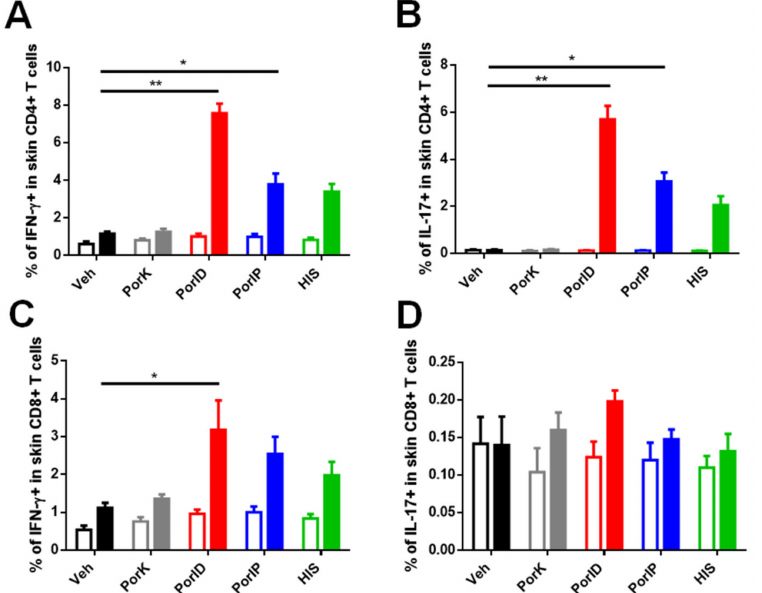
Figure A2. Percentage of functional CD4+ and CD8+ T cells in skin. C57BL/6J mice were injected intradermally in the ear with vehicle (Veh), proteinase K-digested porins (PorK), porins (PorID), or intraperitoneally with porins (PorIP) or heat-inactivated S . Typhi (HIS) at day 0. All groups were boosted at day 14 with porins injected intradermally in the ear. Count of the percentage of IFN- γ - ( A ) and IL-17- ( B ) producing CD4+ T cells found in skin at day 28. Same population percentages were analyzed for skin CD8+ T cells ( C , D ) ( n = 7; 2 independent experiments; significant difference for a Kruskal–Wallis test ** p < 0.05 * p < 0.1 with Dunn’s multiple